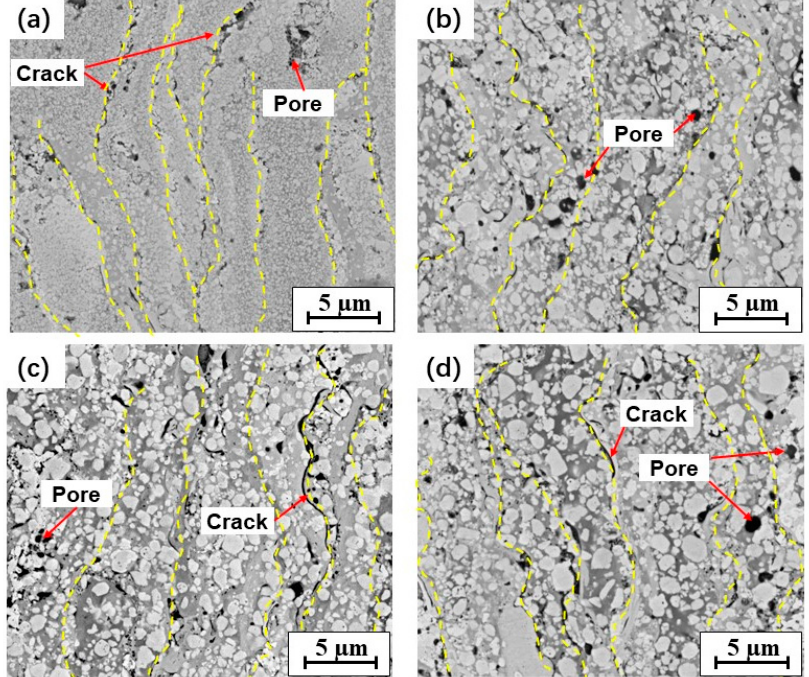
Figure 4. Cross-sectional BSE–SEM images of the studied WC–10Co–4Cr coatings: ( a ) N; ( b ) B1; ( c ) M; ( d ) B2. Table 4. EDS analysis results (wt%) of the detected points marked in Figure 6.